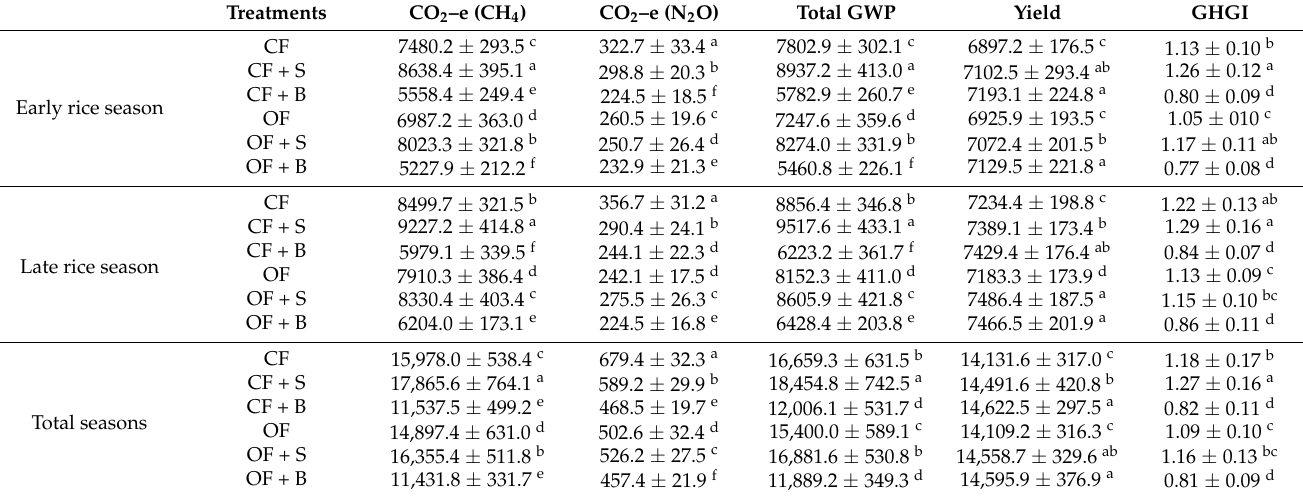
Table 2. Grain yield (kg ha − 1 ), yield-scaled GWP (kg CO 2 -Eq kg − 1 ), and GHGI in the double rice cropping system under different